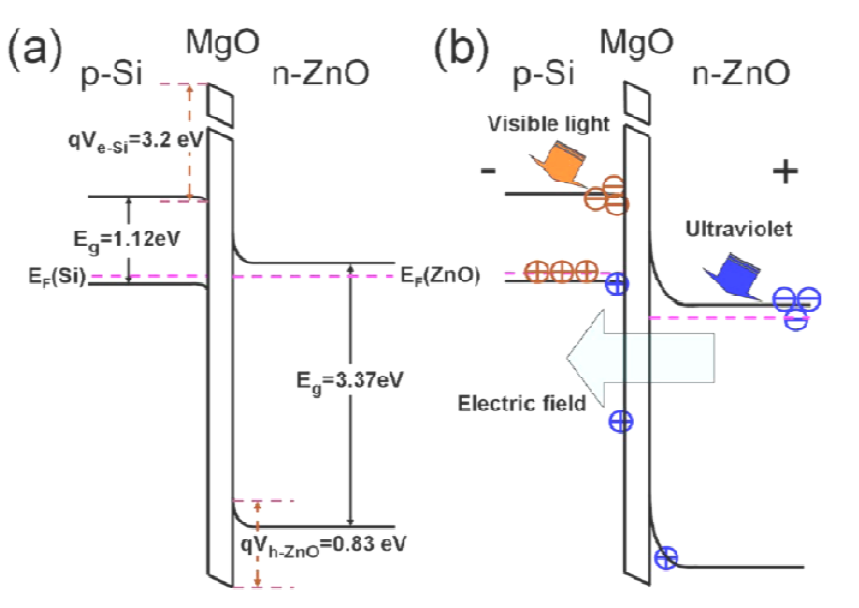
Figure 15. The energy-band diagrams of n -ZnO/insulator-MgO/ p -Si heterojunctions (a) under zero bias and in dark and (b) under reverse bias and in light illumination. The circles with a line and a cross inside stand for the photogenerated electrons and holes, while the brown and blue relate to the visible and UV excitation in depletion regions of p -Si and n -ZnO, respectively